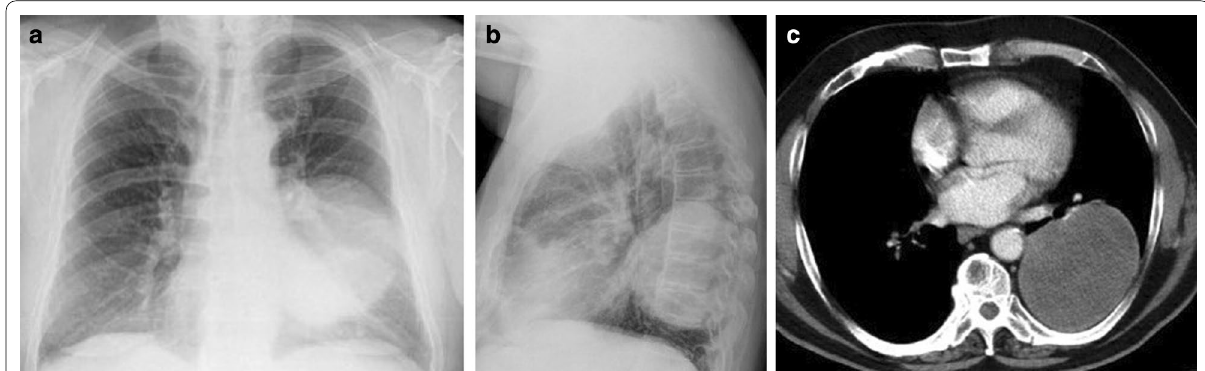
Fig. 14 Diagnosis: leiomyosarcoma. Technique: standard chest radiography and contrast-enhanced chest CT. Description: Postero-anterior and lateral chest radiographs ( a , b ) in a 64-year-old man show a well-delineated mass located posteriorly in the left lower lobe. Axial contrast-enhanced CT ( c ) reveals a smooth lobular mass with intralesional necrosis. There is no locoregional invasion of the adjacent structures. Imaging findings are relatively aspecific. On histopathologic examination, findings were consistent with a